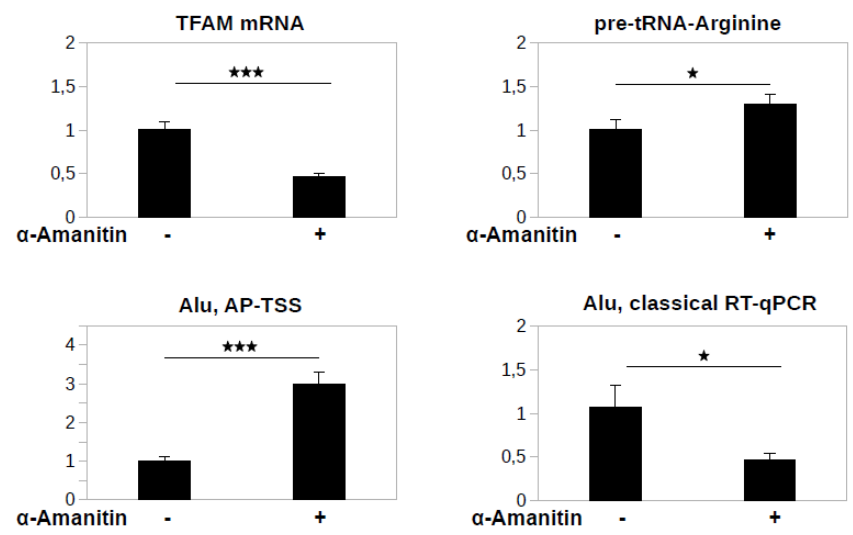
Figure 5. Application of AP-TSS to Alu transcripts. ( A ) RNA extracted from HeLa cells was reverse transcribed (RT) (lane 1) or not (lane 2), using RP-Alu as a primer. Elongation was carried out using OT-Alu. Elongation products were amplified by PCR using P1 and P-Alu, and PCR products (79 bp, arrowhead on the right) were run on a 1.5% EtBr-agarose gel. Lane M is the 50-bp DNA ladder (New England BioLabs). ( B ) Four dilutions of total RNA were reverse transcribed using RP-Alu as primer, the elongation of the cDNA was performed by OT-Alu and 1/50 of each sample was used for the qPCR with P-Alu and P1 primers. Graph shows the triplicates of Ct values as a function of the logarithm of the corresponding RNA mass (in ng). The equation and R 2 of the regression line (in red) are indicated. ( C ) HeLa cells were untreated or treated for eight hours with 50 µg/mL α-amanitin and RT-qPCR with primers hybridizing to pre-tRNA-Arginine, TFAM mRNA or Alu sequence (Alu, classical RT-qPCR) were performed. RNA was reverse transcribed using RP-Alu as a primer and elongation was carried out using OT-Alu, followed by qPCR using P1 and P-Alu (Alu, AP-TSS). All the qPCR results were normalized to 28S rRNA, a stable rRNA transcribed by RNA polymerase I, and all values were compared to untreated HeLa sample. The bars represent the average values from three biological and two technical replicates for each sample. Error bars represent the standard deviations. P-values were calculated by paired two-tailed Student t-test ( n = 3). NS, not significant, * p < 0.05, ** p < 0.01, *** p < 0.001.